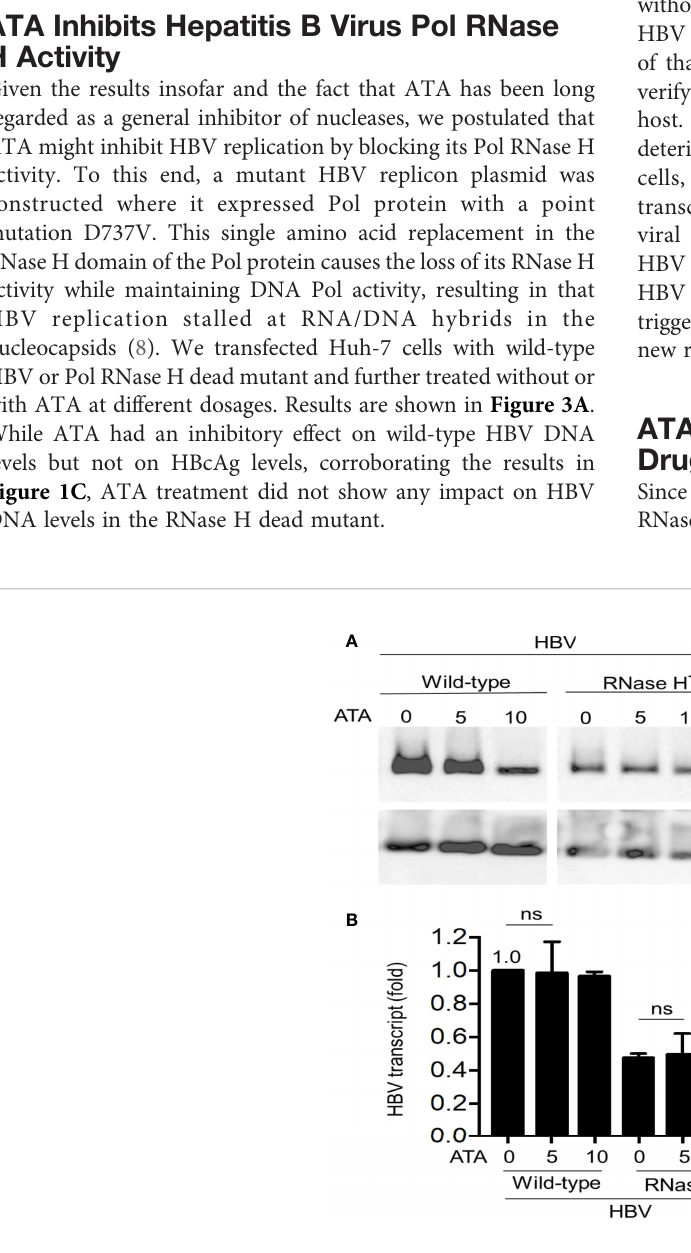
FIGURE 3 | ATA does not affect the Pol RNase H mutant HBV replication in hepatocytes. Huh-7 cells were transfected with an RNase H-defective HBV replicon plasmid (HBV1.5 D RNase H). At 24 h after transfection, cells were treated with or without ATA for 48 h, and HBV nucleocapsids in cell lysates were estimated (A) using the NAGE assay followed by Southern or Western blotting with HBV DNA probes or anti-HBc antibody (NAGE assay). (B) Total RNA was extracted in panel (A) and HBV transcripts were measured by RT-qPCR normalized by GAPDH. ns, not signi fi cant (two-tailed, unpaired Student ’ s t-test). Data are mean ± SEM of three independent experiments. All Western blotting data are representative of three independent experiments. ATA, aurintricarboxylic acid; Pol, polymerase; HBV, hepatitis B virus; NAGE, native agarose gel